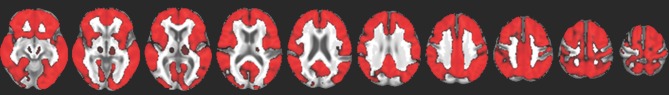
Red indicates voxels with a significant positive association between FBB uptake and age (TFCE-corrected p < 0.05), overlaid on a study-specific structural image. This association was evident throughout the cortex and in the thalamus but not in the striatum.